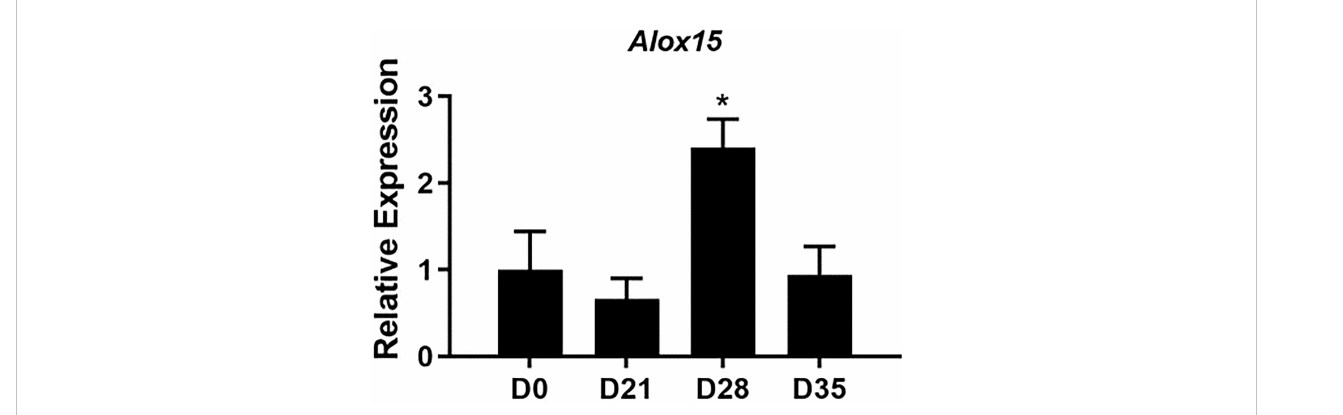
FIGURE 1 Expression of Alox15 mRNA over the time-course of mLA. WT C3H mice were infected with B. burgdorferi and groups of mice were sacri fi ced on the days indicated. The expression of Alox15 mRNA in ankle joints was determined and normalized to Nid1 and reported relative to D0 (uninfected) levels. n=10/group. *p<0.05 by one way-ANOVA with Dunnett ’ s test, compared to